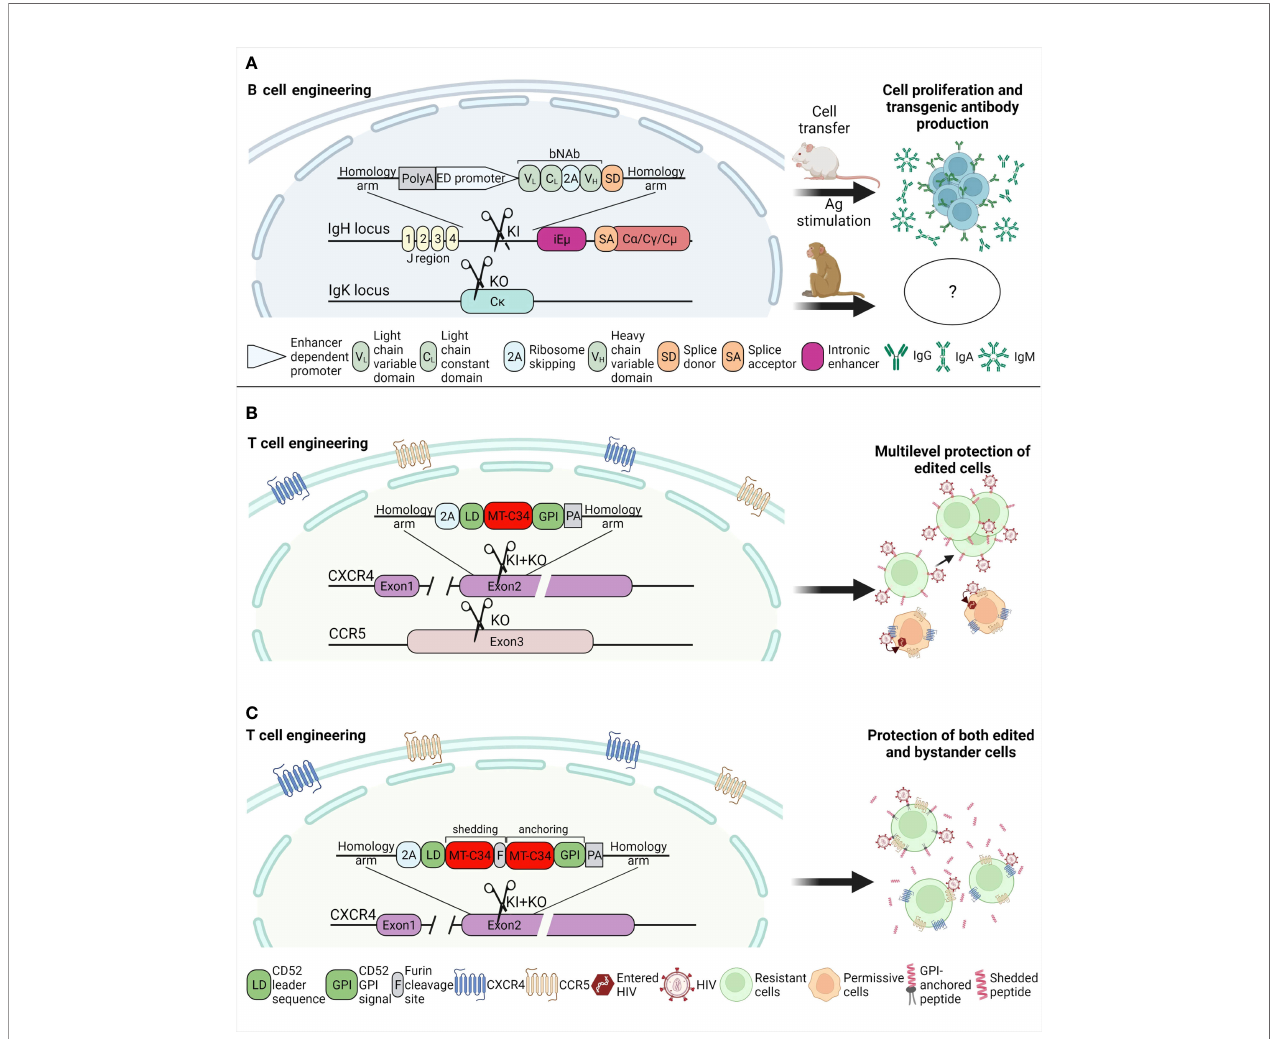
FIGURE 2 | Perspective HDR-based strategies that provide strong and broad protection against HIV. (A) Mature B lymphocytes engineered via knock-in of bNAb into IgH locus are capable to proliferate after adoptive transfer to syngeneic mice and immunization with cognate antigen and produce a high titer of anti-HIV Ig of different classes. Hopefully, preclinical trials on primates and clinical studies will be successful as well. The concept of full-length light chain and variable domain heavy chain knock-in-out at IgH locus was adapted from the papers (Hartweger et al., 2019; Nahmad et al., 2020). The single-chain antibody was introduced between VDJ and C segments that preserves mechanism of Ig class switch, while additional IgK gene KO prevents mispairing of light chain with transgenic heavy chain. (B) . Knock-in-out of MT-C34 peptide from gp41 protein into the CXCR4 locus with a parallel ablation of CCR5 gene ensures full tropism-independent protection of engineered CD4 + T cells from HIV. (C) . A combination of secreted and GPI-anchored forms of MT-C34 via peptide concatemeric construct knocked-in into CXCR4 gene will provide the selection of CD4 + T cells that are resistant to HIV and secrete the MT-C34 peptide which will shield non-edited cells from HIV infection. The GPI-anchored C-peptide KI concept was described previously in our paper (Maslennikova et al., 2022) and here it was complemented with CCR5 KO and peptide secretion strategy which was reported earlier and called SAVE (Egerer et al., 2011). The symbol and pictogram labels (grouped for panels B, C ) are shown at the bottom of pictures. All images were created with